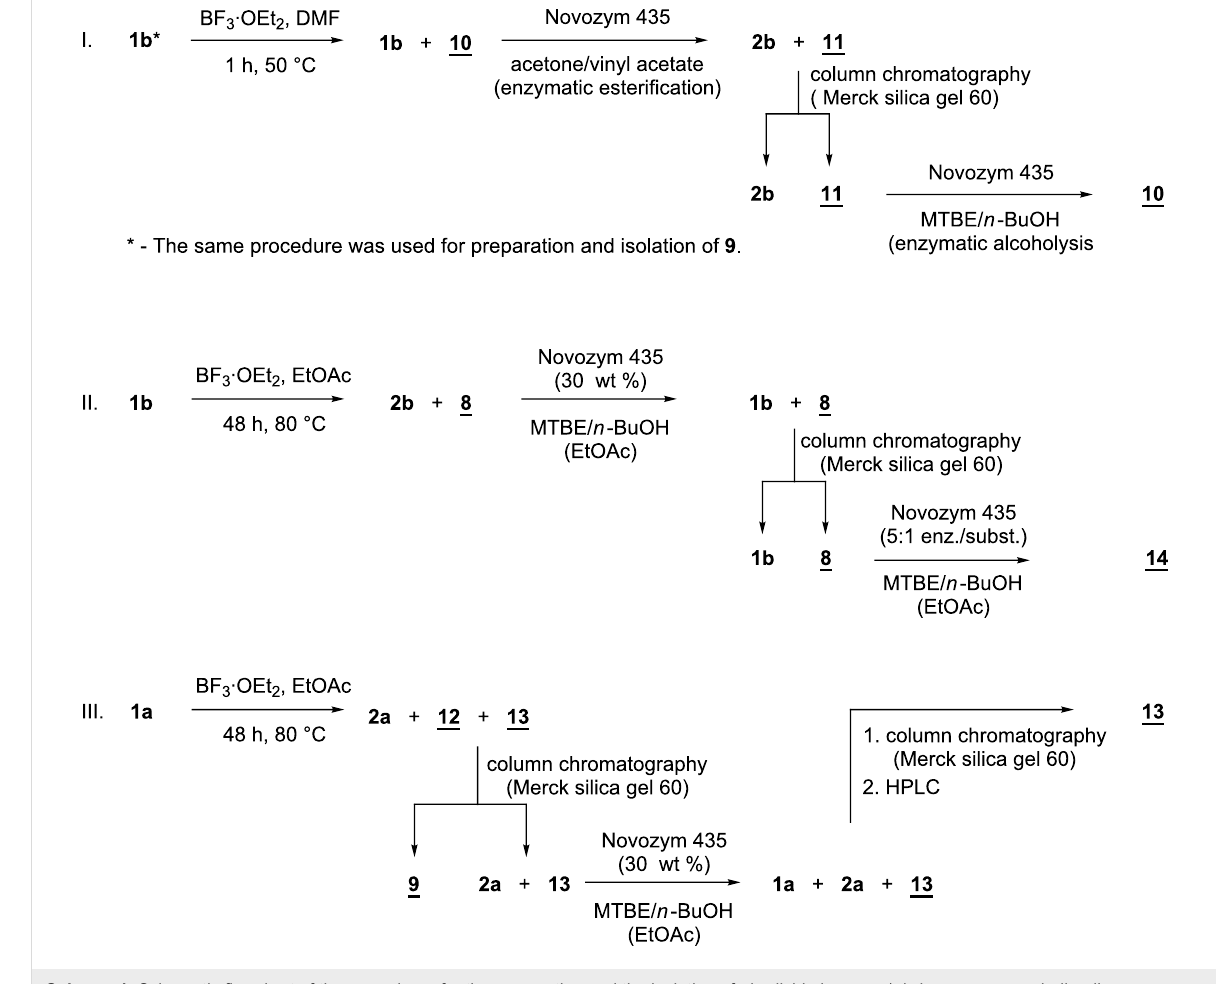
moiety (with the stereogenic centers C-2 and C-3), and the 1,4- benzodioxane moiety (C-10 and C-11) (see Figure 4). In